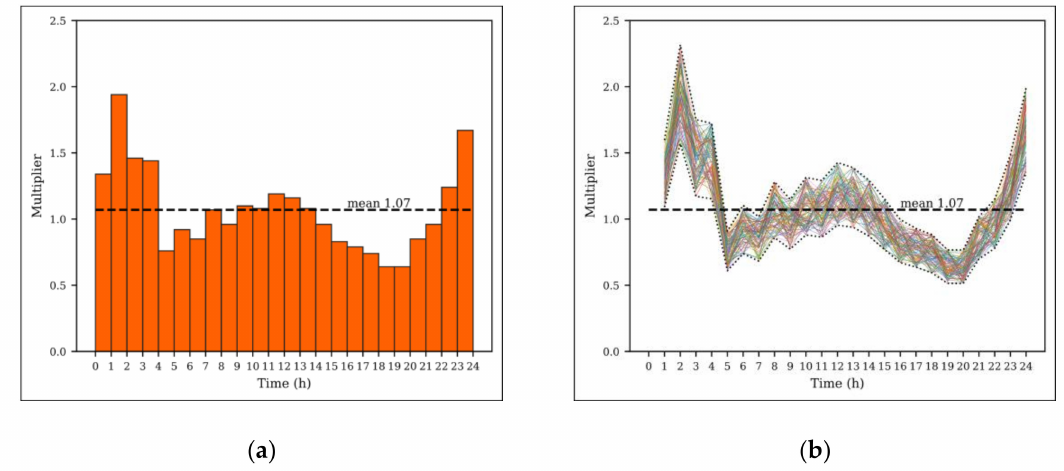
Figure2. Nodalwaterconsumptiondailypattern: ( a )Averagepatternand( b